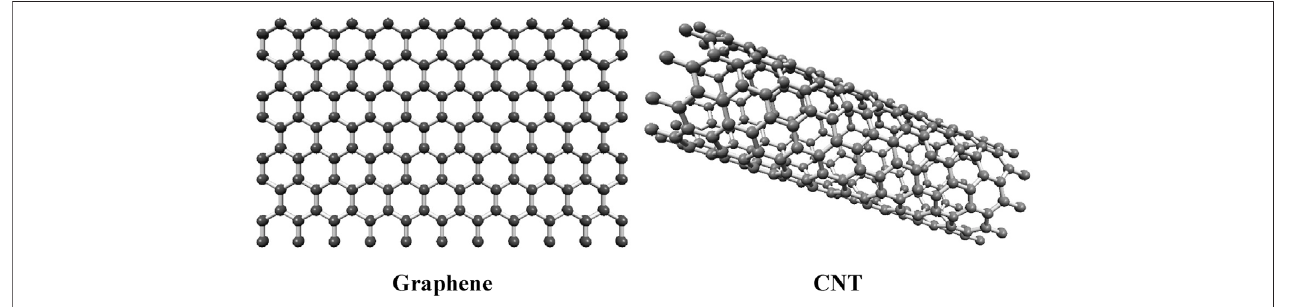
FIGURE 4 | Schematic structure of Graphene and